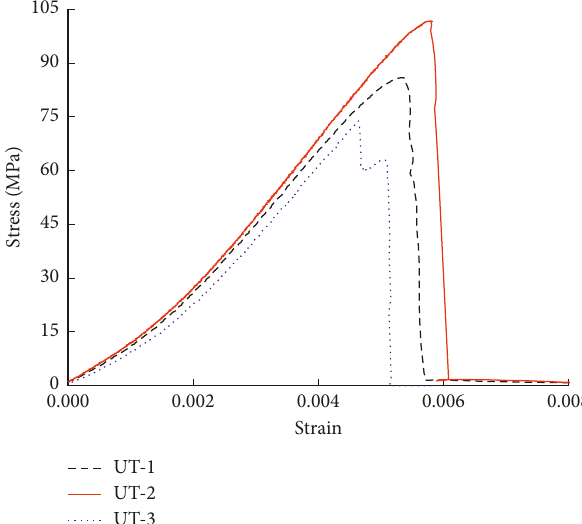
Figure 5: Stress-strain curves of specimens under uniaxial com- pression. UT-1, UT-2, and UT-3 denote the uniaxial compression test of specimens 1, 2, and 3, respectively.